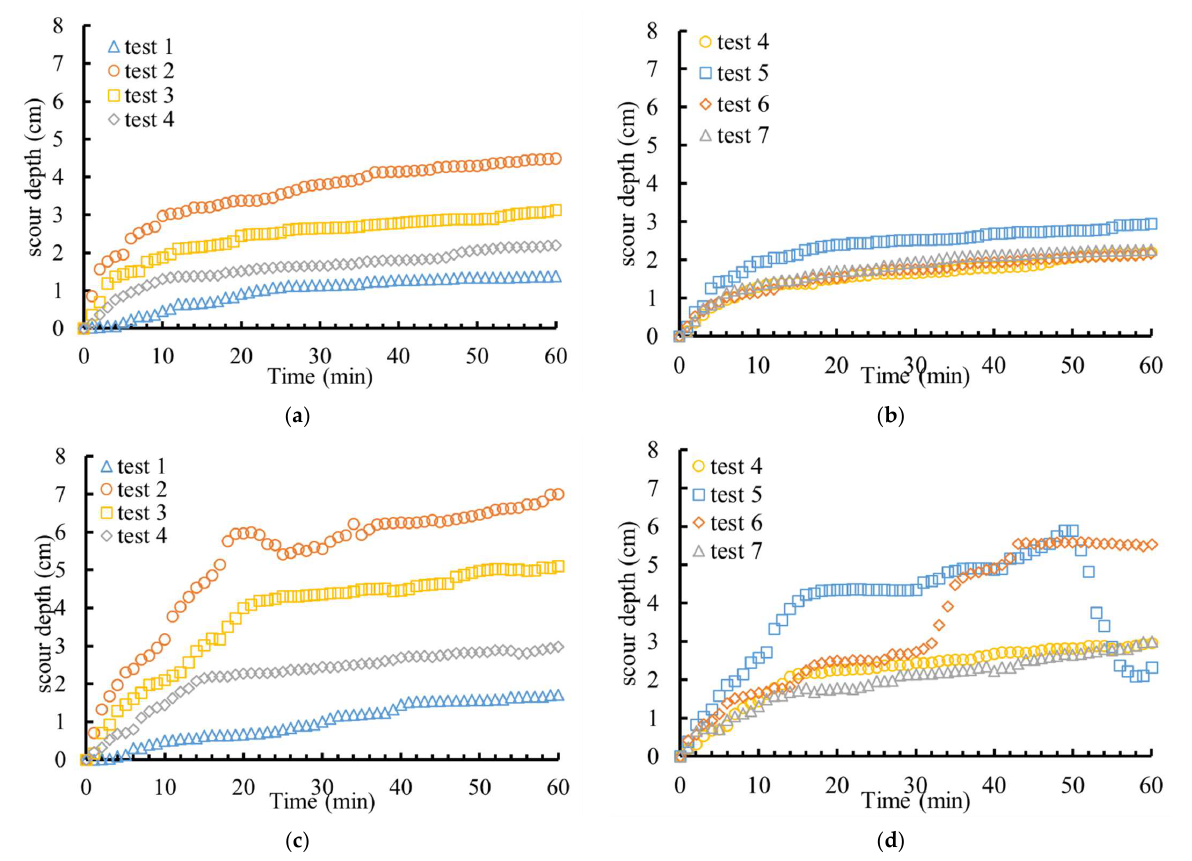
Figure 4. Temporal evolution of scour depth in front of the pier every minute: ( a , b ) tests without debris jam, ( c , d ) equivalent tests in the presence of debris jam.